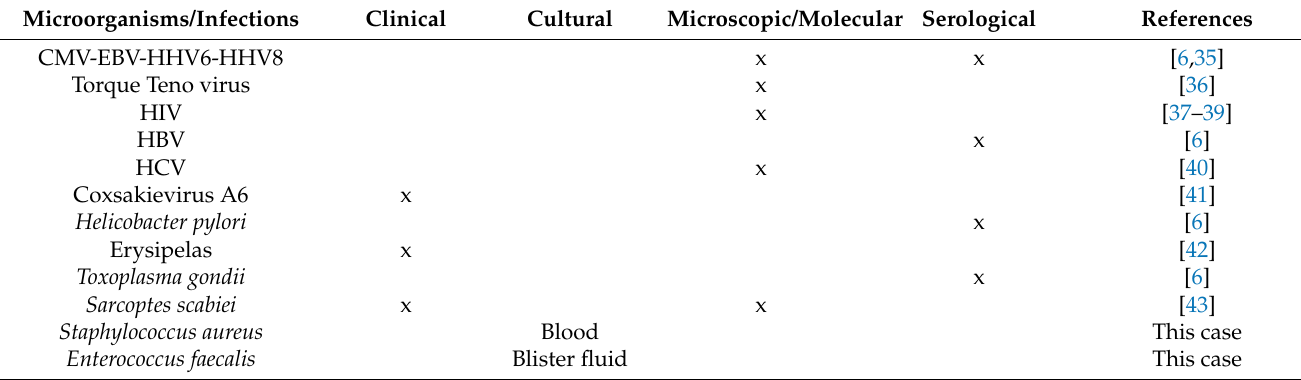
Table 2. Infectious agents suspected of acting as triggers of bullous pemphigoid and type of diagnosis of infection. Microorganisms/Infections Clinical Cultural Microscopic/Molecular